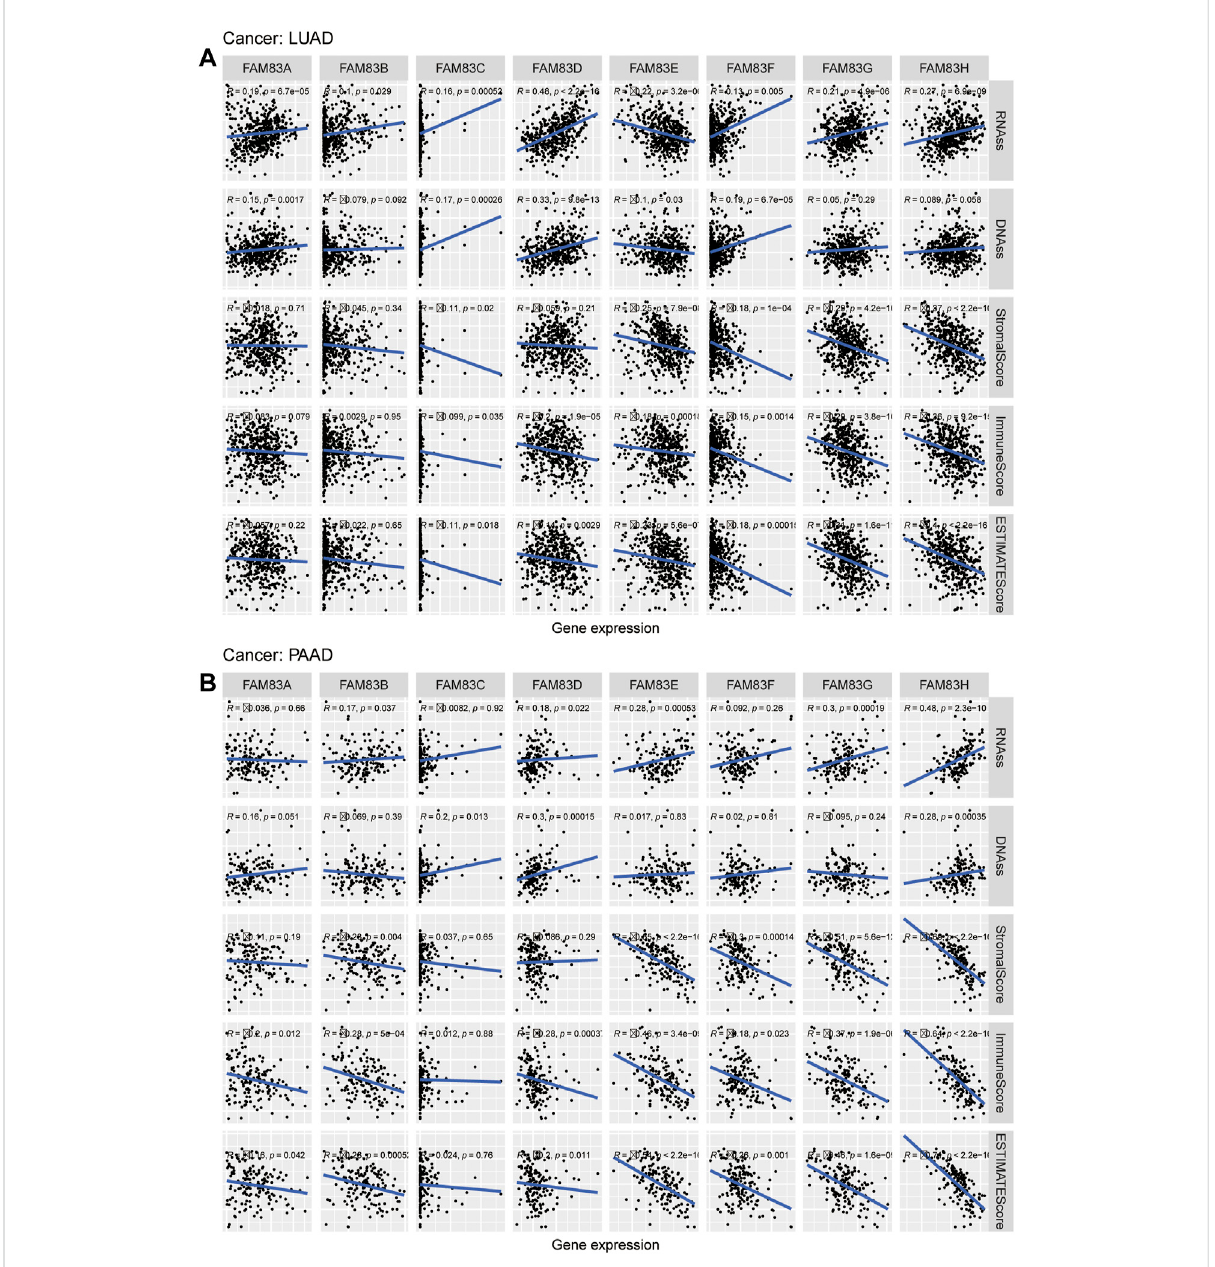
FIGURE 7 Relevance analysis of the FAM83 family genes with stemness scores and microenvironment scores in LUAD (A) and PAAD (B) .